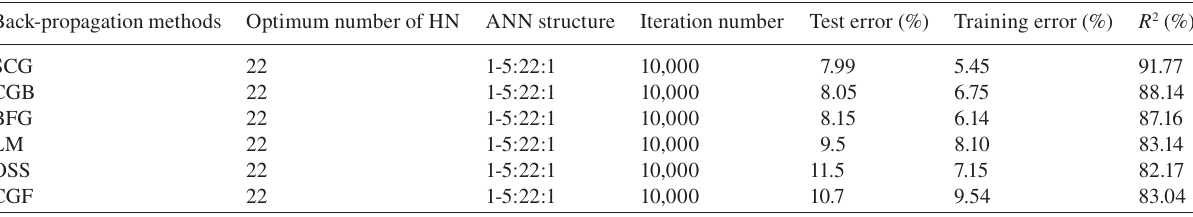
Table 2 Values of displacement failure point of the structures. ( δ failure). Back-propagation methods Optimum number of HN